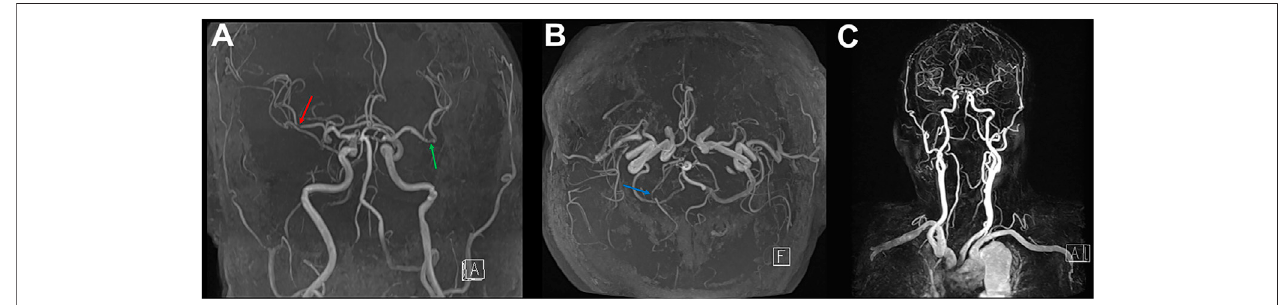
FIGURE3| Contrast-enhancedmagneticresonanceangiographyforthebrainandcarotidonday7post-vaccination (A,B) Brainmagneticresonanceangiography showsfocalstenosisattheright(redarrow)andleft(greenarrow)insularsegment(M2)onmiddlecerebralarteriesandpost-communicatingsegment(P2,bluearrow)on the right posterior cerebral artery. (C) No vascular abnormality detects on carotid magnetic resonance